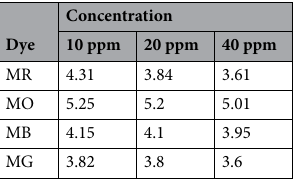
Table 1. Initial pH of the dye solution.